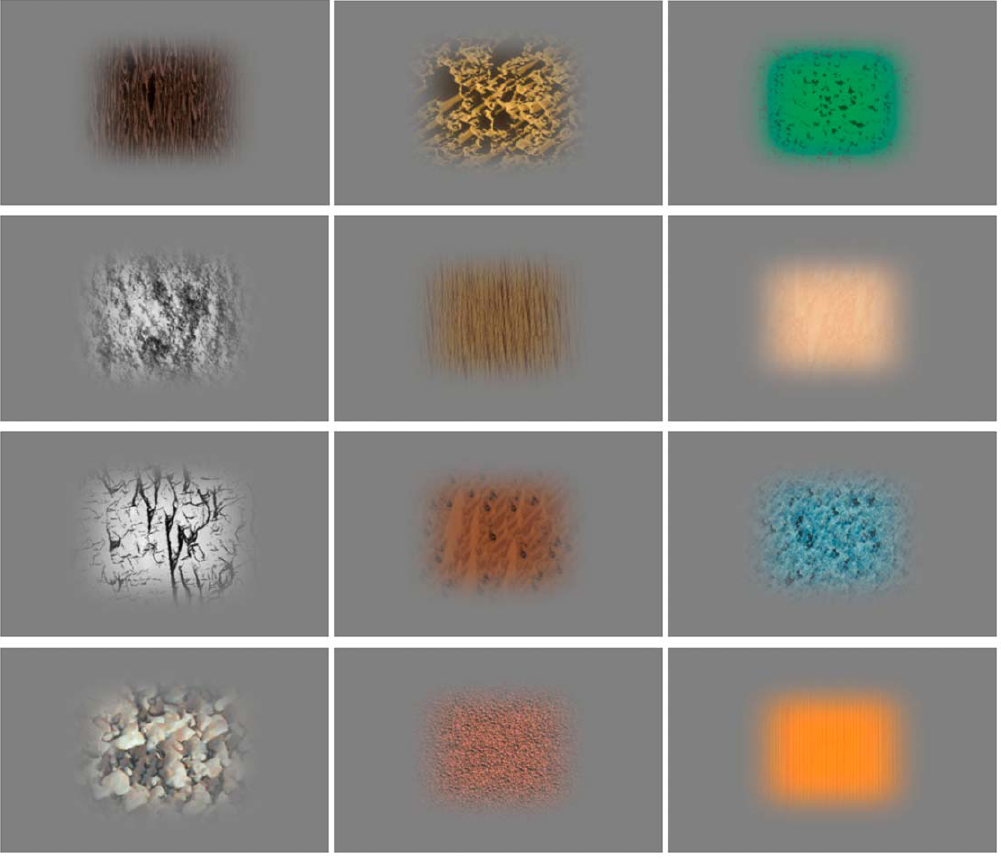
Figure 1. Example of textures used in the experiment. Textures were presented against a grey background. Computer-generated and photographed textures were used, some coloured and others in greyscale.